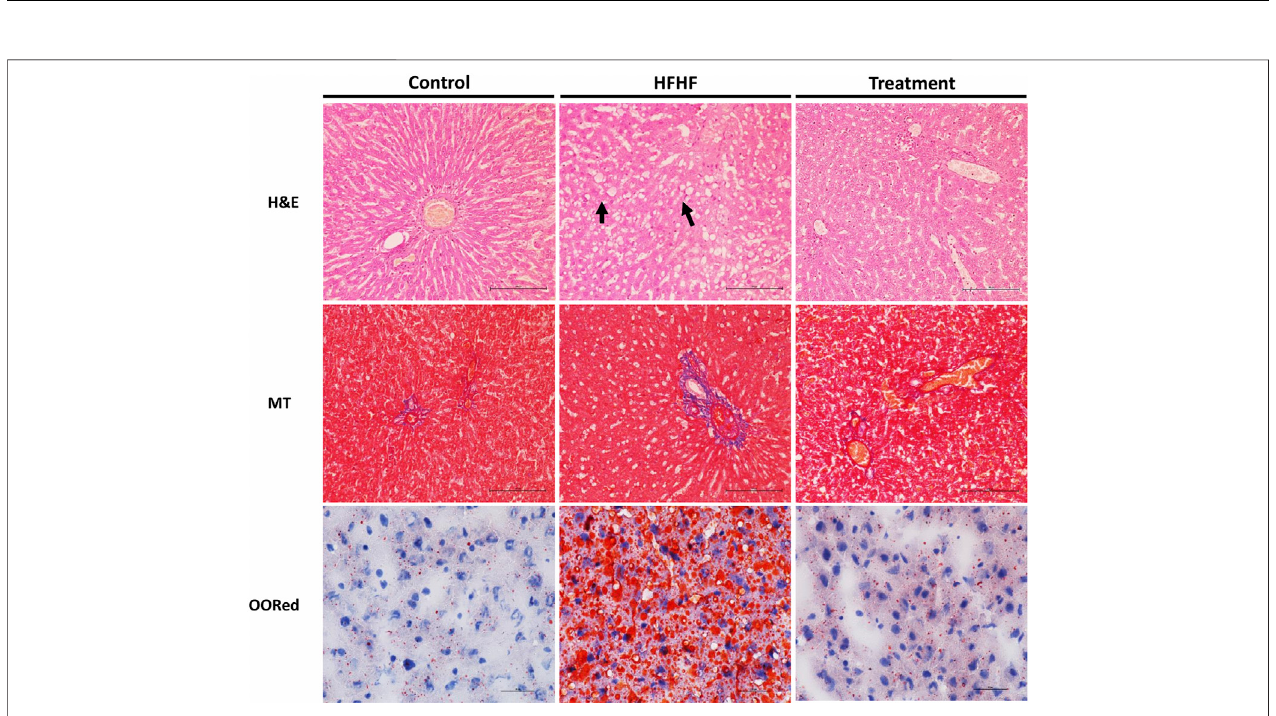
FIGURE3| Representative sections ofrat livershowing histological alteration inthe liverbyH&Estain(40X) arrows indicating fat globules, MTstain(40X)indicating fi brosis, and Oil-O-Red stain (60X) indicating the fat accumulation.